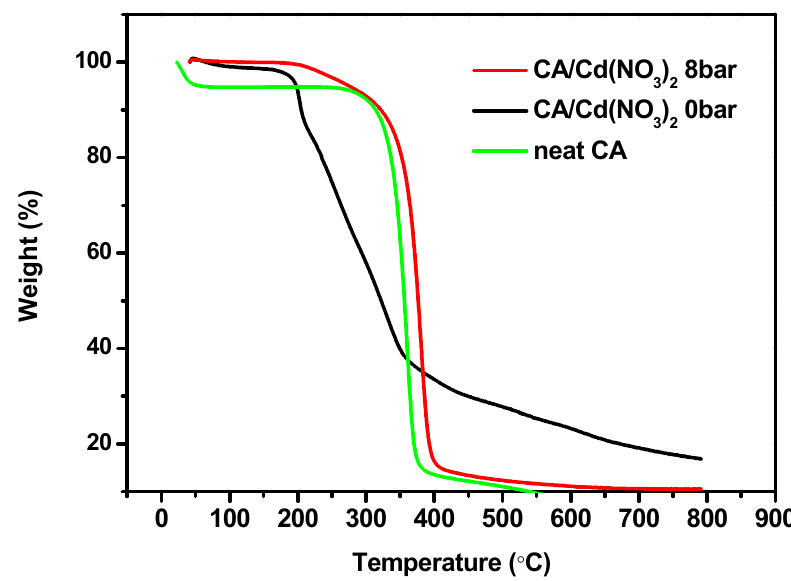
Figure 4. TGA analysis of neat CA and CA / Cd(NO 3 ) 2 · 4H 2 O polymer matrix at 0 bar and 8 bar.